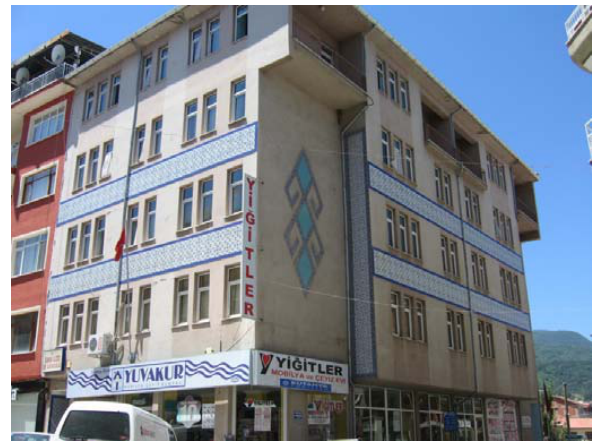
Fig. 19. Fig. 18. Lateral facade of the